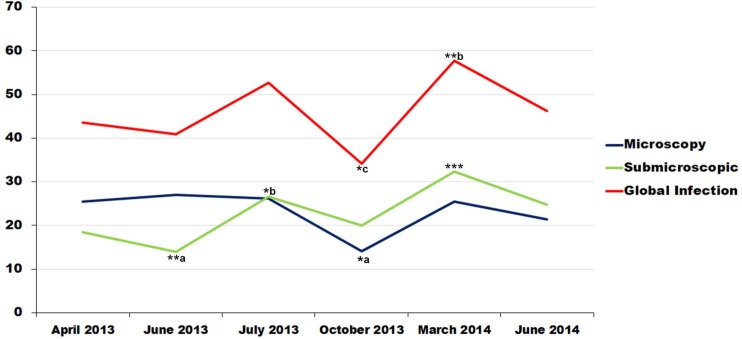
Global prevalence of malaria infection in Dienga.*a: Significant difference between the prevalences of October 2013 and those of other sampling periods except June 2014, in microscopic infection. ** a: Significant difference between the prevalences of June 2013 and those of other sampling periods, in submicroscopic infection. *b: Significant difference between the prevalences of July 2013 and that of June 2013, in submicroscopic infection. ***: Significant difference between the prevalence of March 2014 and those of other sampling periods except July2013 and June 2014, in submicroscopic infection. *c: Significant difference between the prevalence of October 2013 and that of March 2014, in Global infection. **b: Significant difference between the prevalence of March 2014, April and June 2013 in Global infection.